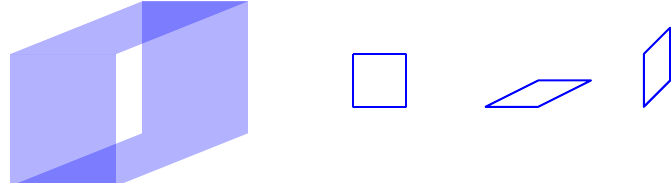
Figure 8: Hamiltonian model for the (cid:90) electric model. In the top row, the edges are 2 labelled by numbers without a prime, while the faces are labelled by numbers with a prime. The operators in the top row only commute in the zero flux sector, which is the ground state subspace of the bottom-right plaquette